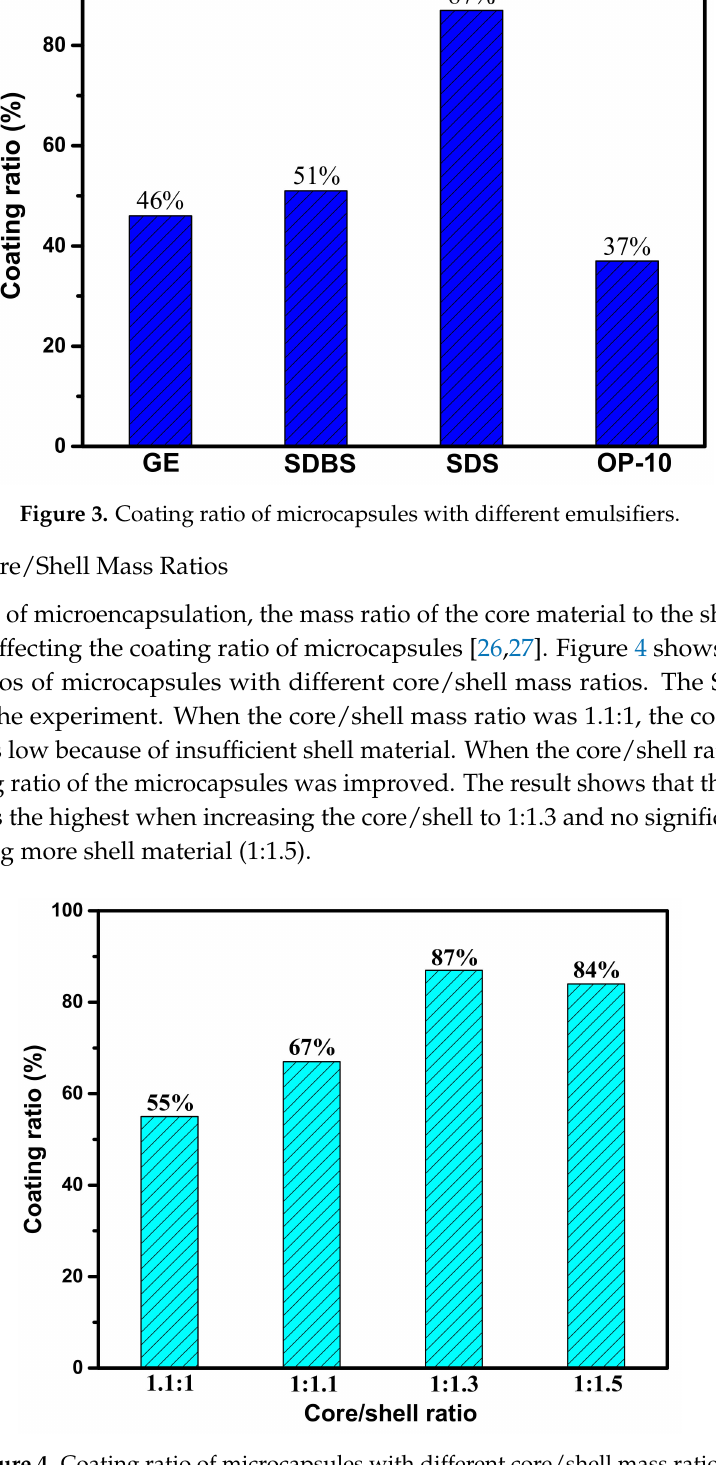
Figure 4. Coating ratio of microcapsules with different core/shell mass